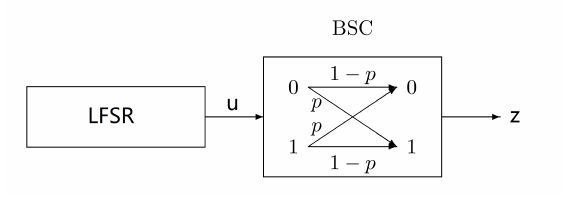
Figure 6: Model for a bitwise fast correlation